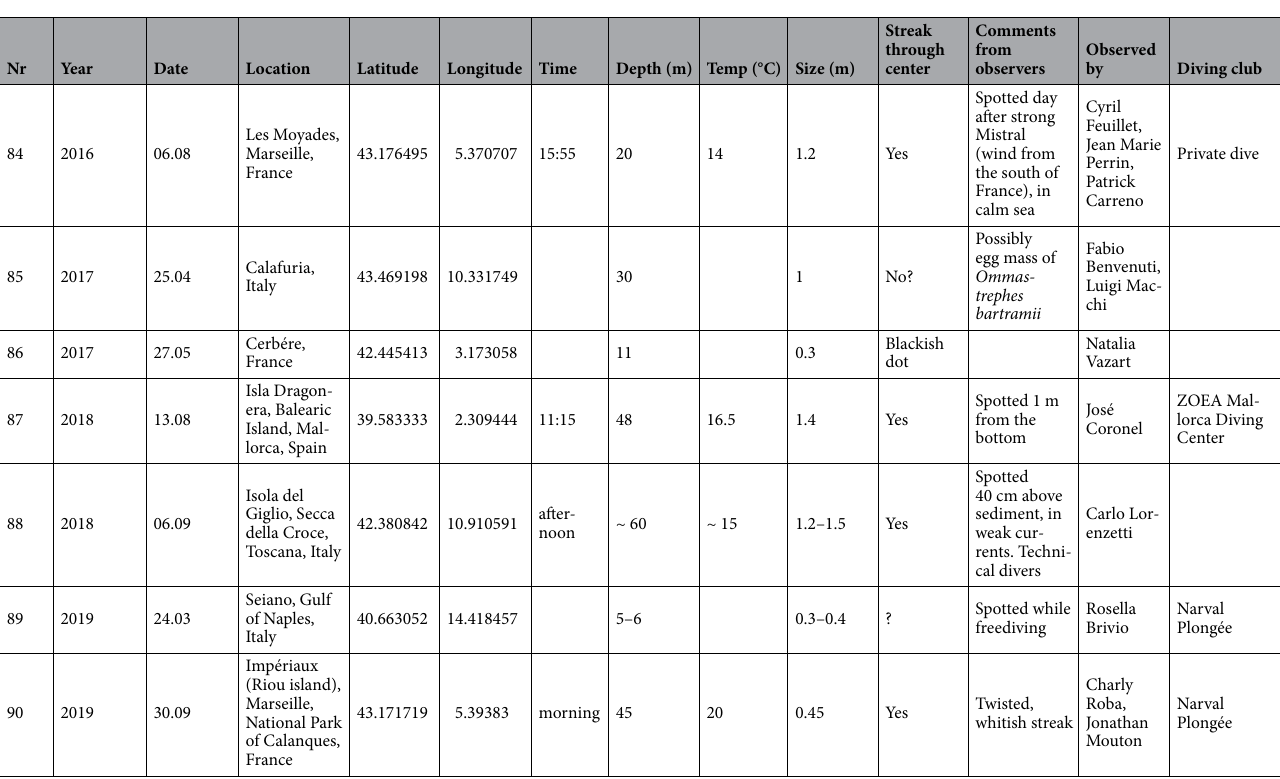
Table 1. Synopsis of gelatinous sphere observation data from NE Atlantic Ocean, including the Mediterranean Sea, ~ 1985 to 2019. The data from this study are combined with data from Ringvold and Taite 1 . Estimated size in diameter, and latitude and longitude in decimal degrees, DD (approximate locations). (Records by Adolf Naef 2 is not included in count of spheres.) * Observations 73 and 74 might be the same